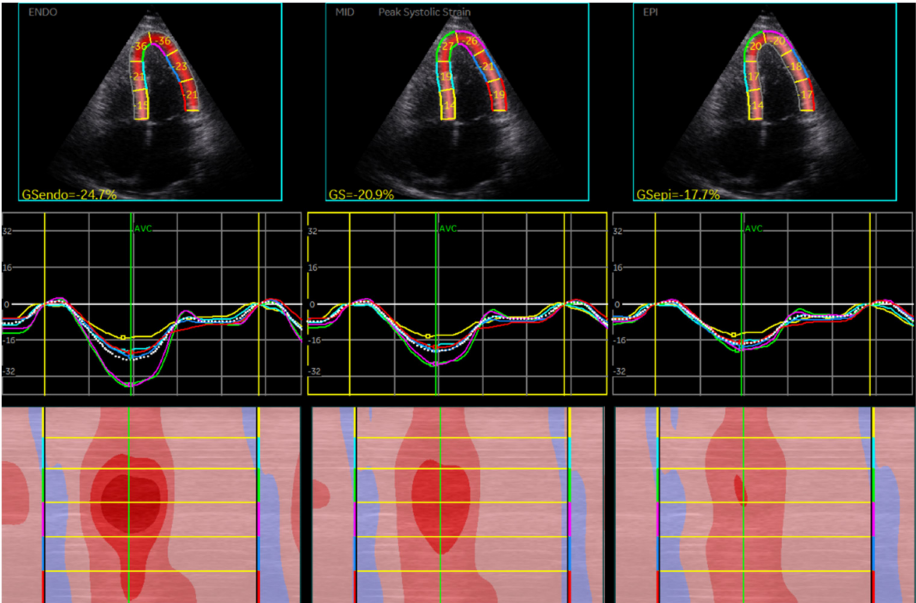
Figure 1. Example of left ventricular (LV) multilayer global longitudinal strain (GLS) in transthoracic echocardiography (TTE) four-chamber